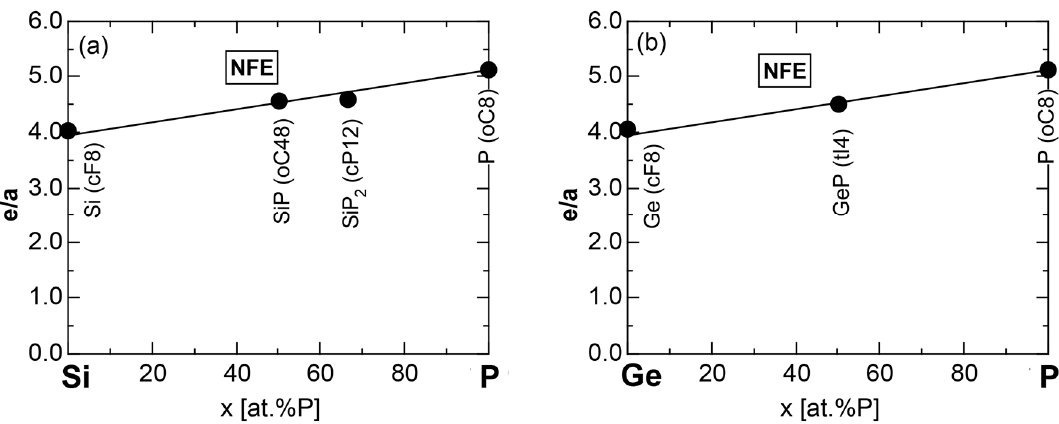
Figure 69. Composition dependence of e/a for intermetallic compounds and pure elements in ( a ) Si-P and ( b ) Ge-P alloy systems. The NFE method is exclusively employed. The linear interpolation lines are drawn by connecting end points of pure elements in the respective alloy systems. Symbols in bracket refer to the Pearson symbol for elements and compounds [11].